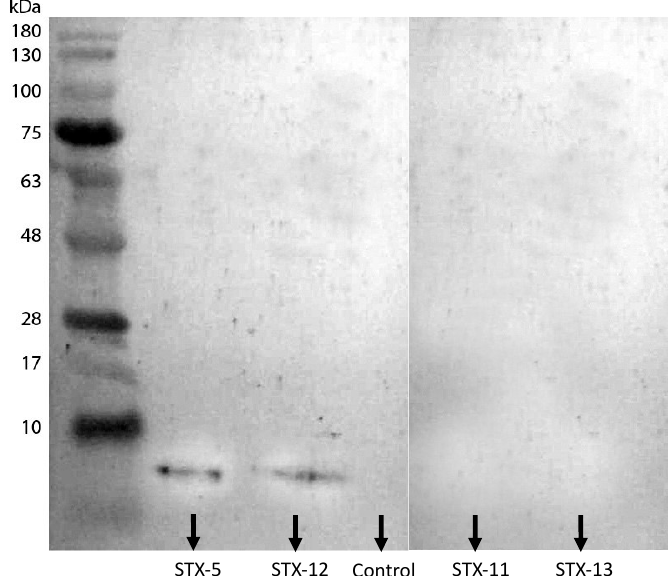
Figure 8. Accumulation of the sarcotoxin IA protein in the juice extracted from fruit of the STX IA transgenic lines STX-5, STX-11, STX-12, and STX-13, and non-transgenic control Pera sweet orange plants by Western blot analysis.